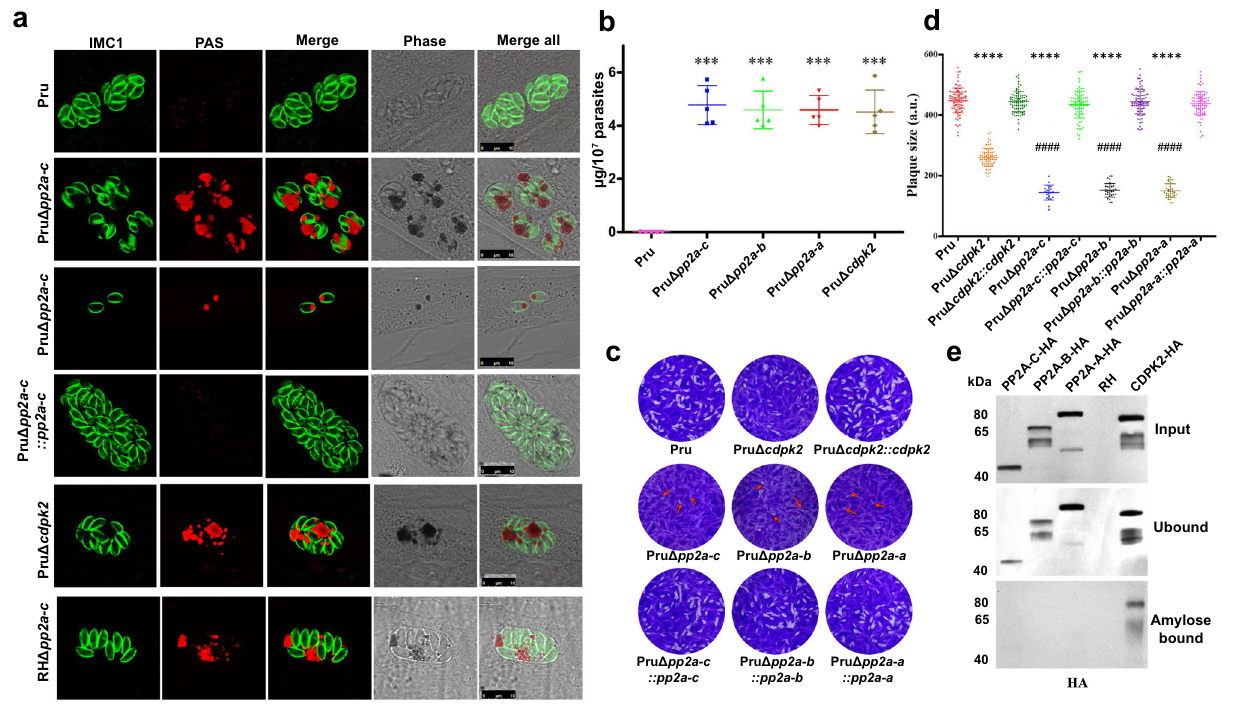
Fig. 2 | PP2A holoenzyme is essential for starch metabolism and lytic life cycle of Toxoplasma gondii . a The wild-type Pru, Pru Δ cdpk2 , Δ pp2a-c and the com- plemented strains were inoculated into HFF cells under normal culture conditions and the amylopectin was stained with PAS (red), followed by immuno fl uorescence detectionoftachyzoiteswithanti-IMC1antibody(green).Thethirdrowshowesthe amylopectin accumulation in the extracellular or newly invaded Pru Δ pp2a-c tachyzoites. Scale bar, 10 µ m. b Quanti fi cation of amylopectin levels in the indi- cated strains. Data represents the mean±SD from fi ve independent experiments. Statisticalsigni fi cancetestedbytwo-tailed,unpaired t testwithWelch ’ scorrection. *** P value=0.0001 (Pru vs Pru Δ pp2a-c ), *** P value=0.0001 (Pru vs Pru Δ pp2a-b ), *** P value=0.0001 (Pru vs Pru Δ pp2a-a ), *** P value=0.0003 (Pru vs Pru Δ cdpk2 ).